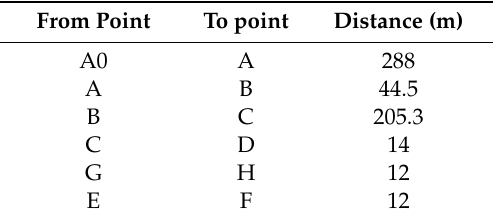
Table 2. Distances between the front wheels of the first nine riders and points G (FWG) and E (FWE) and their Delta. Zarco’s values are in bold. Pilots FWG (m) FWE (m) Δ (FEW − FWG) (m)